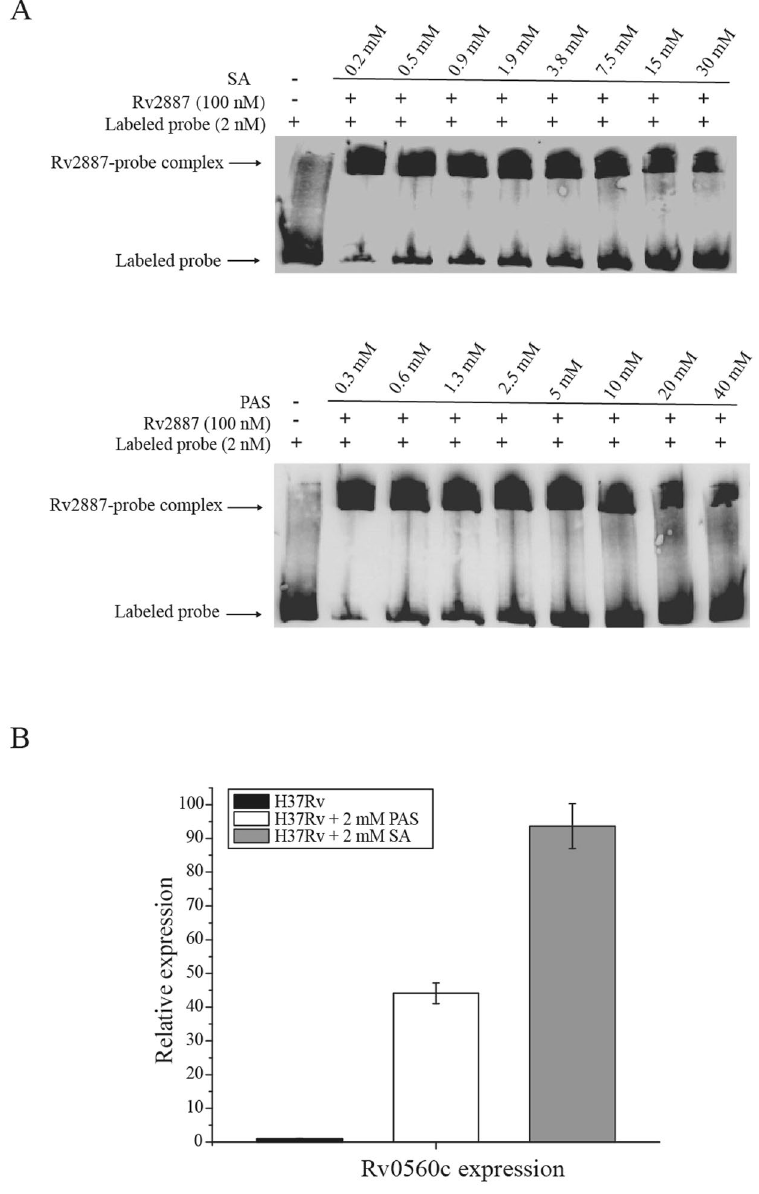
Figure 3. SA/PAS binding attenuates Rv2887 DNA-binding ( A ) EMSA of the Rv2887-DNA complex in the presence of increasing amounts of SA (upper panel) and PAS (lower panel). Dissociation of DNA from Rv2887 was observed on addition of increasing amounts of SA or PAS. ( B ) qRT-PCR analysis of Rv0560c expression in M. tuberculosis H37Rv. Expression of Rv0560c was measured in the presence and absence of 2 mM PAS or 2 mM SA. Values normalized to sigA are expressed relative to the level of Rv0560c in the absence of PAS and SA. Error bars indicate the